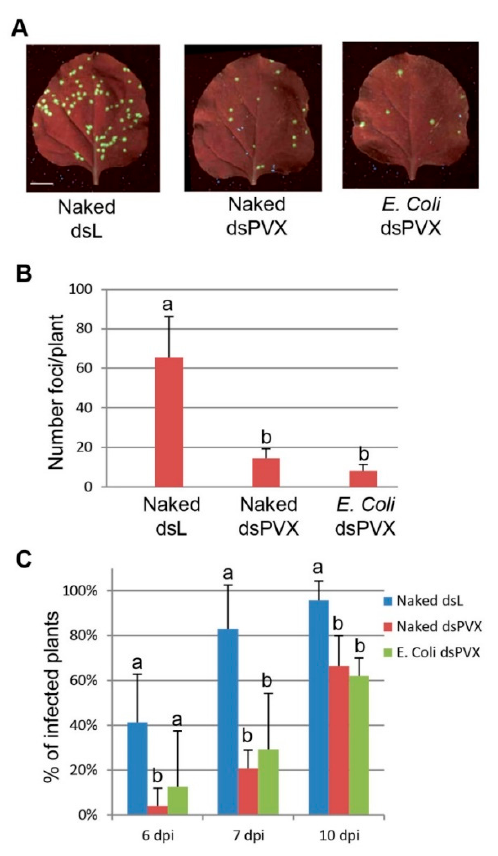
Figure 3. Bacterially produced dsRNA interferes with PVX-GFP infection. Nicotiana benthamiana plants were inoculated with mixtures of PVX-GFP combined with nucleic acid extracts prepared from E. coli accumulating the dsPVX (naked dsPVX) or E. coli -encapsulated dsPVX ( E. coli dsPVX). The total nucleic acid extracted from E. coli expressing the dsL was used as the control. ( A ) Representative inoculated leaves were examined under UV light at 4 days post-inoculation (dpi). Scale bar denotes 1 cm. ( B ) Mena numbers ± standard deviations of infection foci on inoculated leaves of plants with the different treatments at 4 dpi. Different letters indicate significant differences determined by employing Scheff é ’s multiple range test ( p < 0.05). ( C ) Themean percentage ± standard deviations of inoculated plants showing systemic symptoms were monitored at different dpi. Different letters indicate significant differences determined by employing Mann–Whitney U test with a Bonferroni correction for multiple comparisons of alfa = 0.016 ( p <